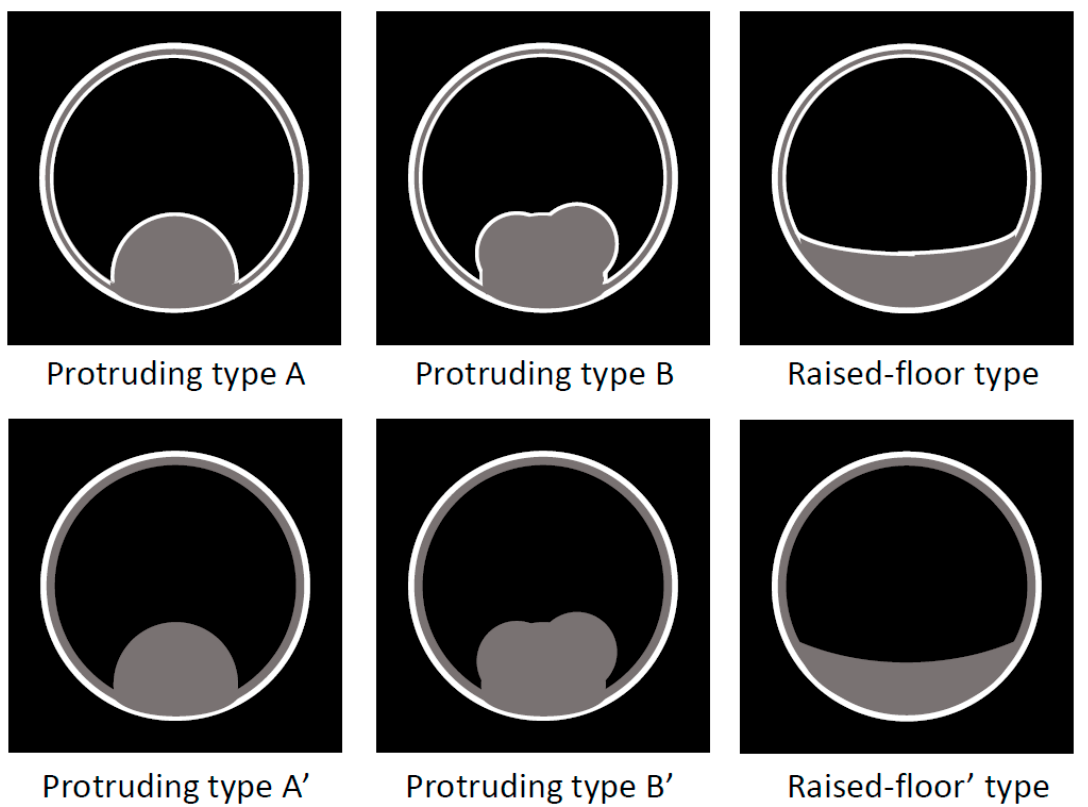
Figure 6. Schema of US/EUS findings in a localized type of IgG4-sclerosing cholecystitis. A localized IgG4-CC could be classed into the protruding type A (with smooth surface and innermost hyperechoic layer); -A’ (with smooth surface and no innermost hyperechoic layer); -B (with nodular surface and innermost hyperechoic layer); -B’ (with nodular surface and no innermost hyperechoic layer); raised-floor type (with innermost hyperechoic layer), raised-floor’ type (without innermost hyperechoic layer).